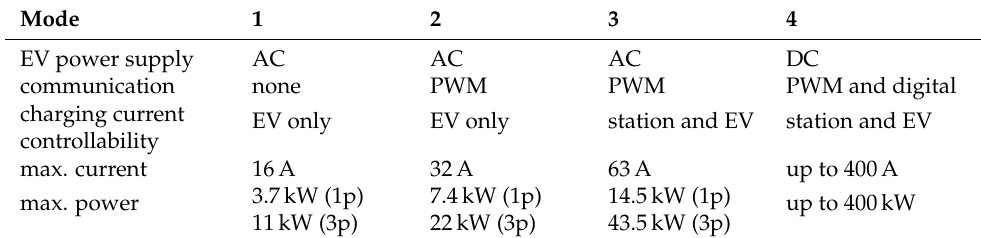
Table 1. IEC61851-1 Charging